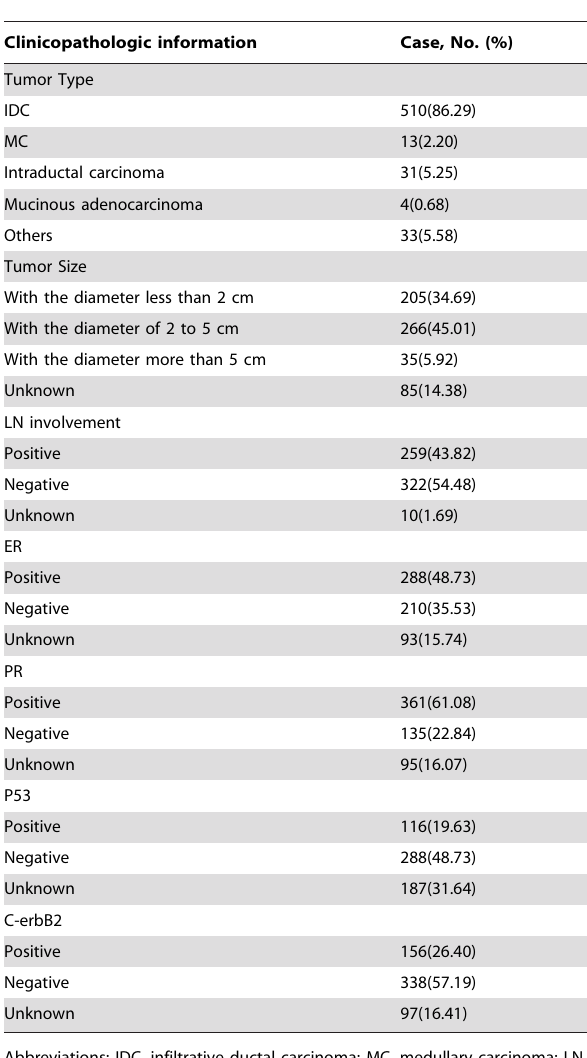
Table 4. Clinicopathologic information of breast cancer patients (n